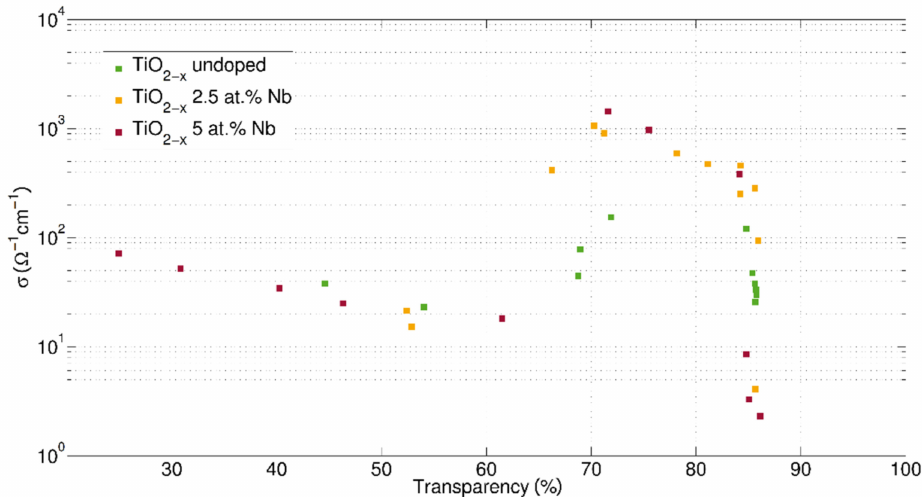
Figure 6. Conductivity σ at room temperature as a function of the transparency for a selection of TiO 2 − x :Nb films. The observed maximum transparency of 85% is limited by reflectivity and could already be increased to more than 90% by some first tests with non-optimized Si 3 N 4 seed layers. In contrast to common TCOs, a clear optimal range of conductivity and transparency at 70–80% can be